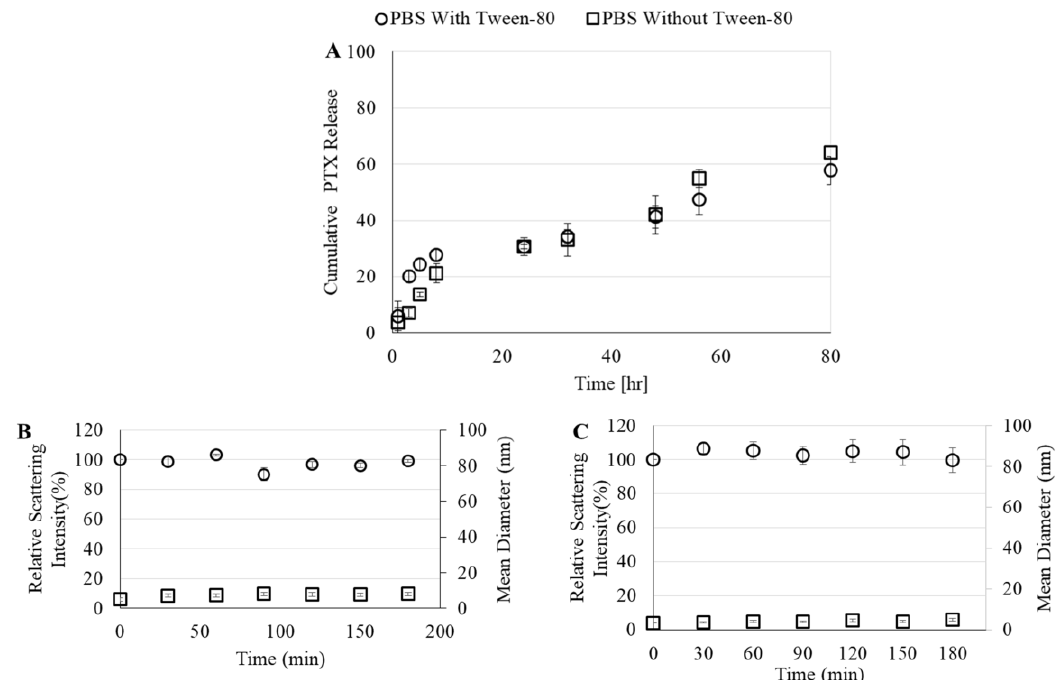
2:1 PTX: FITC-HA-BSA (Figure 5B). FITC-HA-BSA NPs prevent extensive aggregation of PTX in aqueous solutions creating colloidally stable nanometric particles.